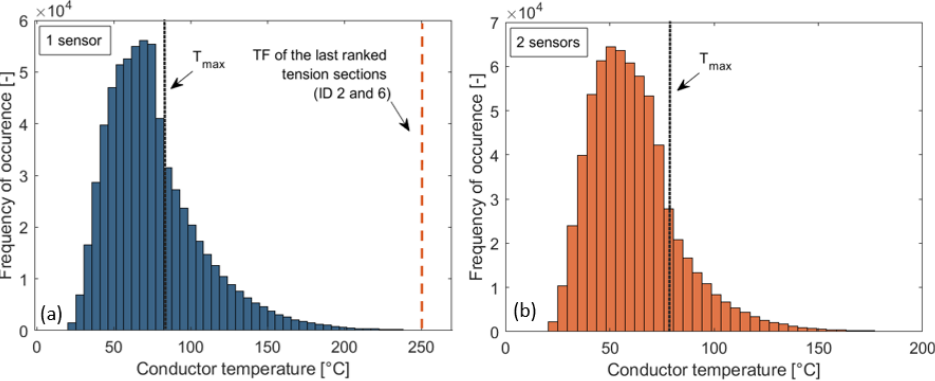
Figure 7. Conductor temperature distribution along the transmission line during the examined period with 10 min sensor-sampling frequency: ( a ) applying one sensor; ( b ) applying two sensors [16].